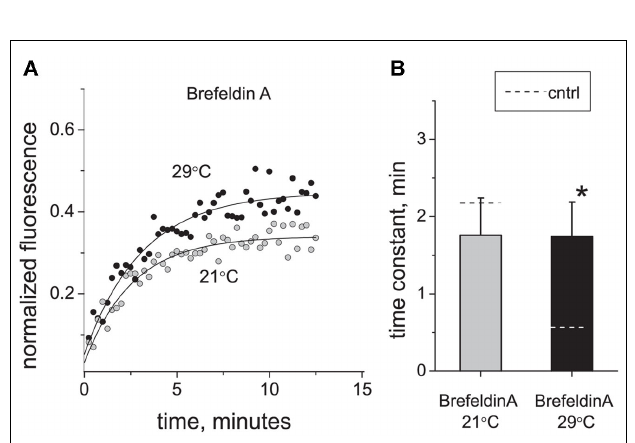
FIGURE 4 | Effect of vesicle traffic inhibition on P2X3 receptor turnover and its temperature sensitivity. (A) Typical examples of P2X3 receptor recovery traces at 21˚C (tau = 2.5min) and 29˚C (tau = 2.8min) after application of Brefeldin A (10 μ g/ml). (B) Effect of Brefeldin A on the time constant of P2X3-DsRed fluorescence recovery after photobleaching. For comparison, control levels in (B) are shown as dotted lines.The asterisk indicates a significant difference from control values at P <